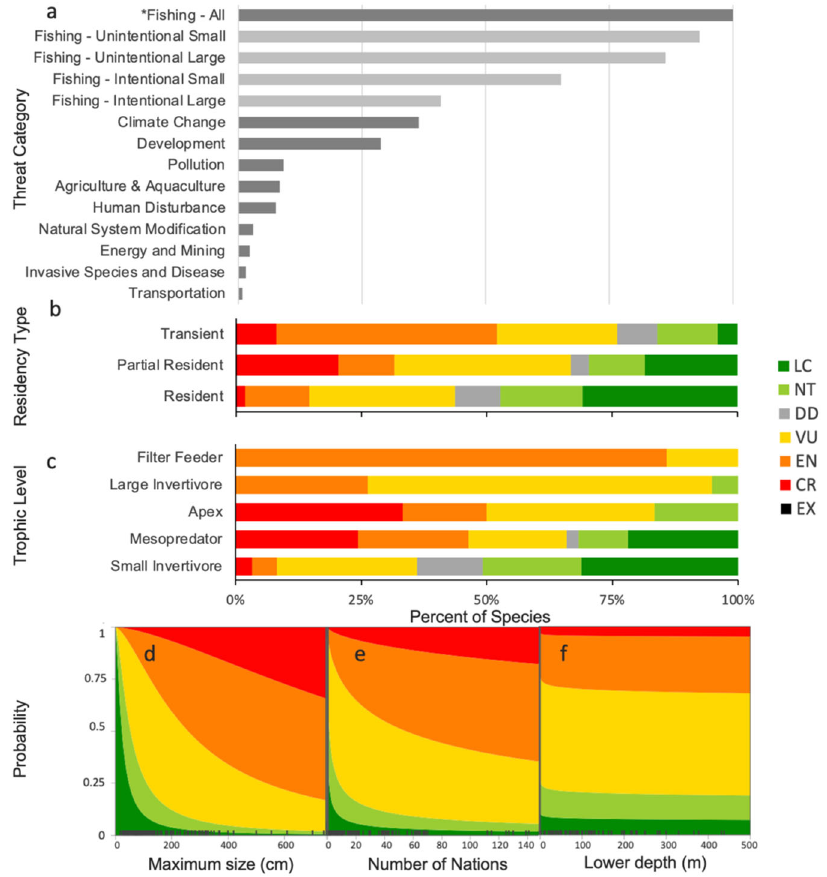
Fig. 2 | High extinction risk of coral reef sharks and rays due to exposure to over fi shing and other threatening processes combined with sensitive life his- tories.a IUCNThreatclassi fi cationforcoralreefspecies.Percentofcoralreefshark and ray species in each IUCN category by b residency patterns, and c trophic positions.Theeffectsof d maximumbodysize, e geographicrangesize(indexedby